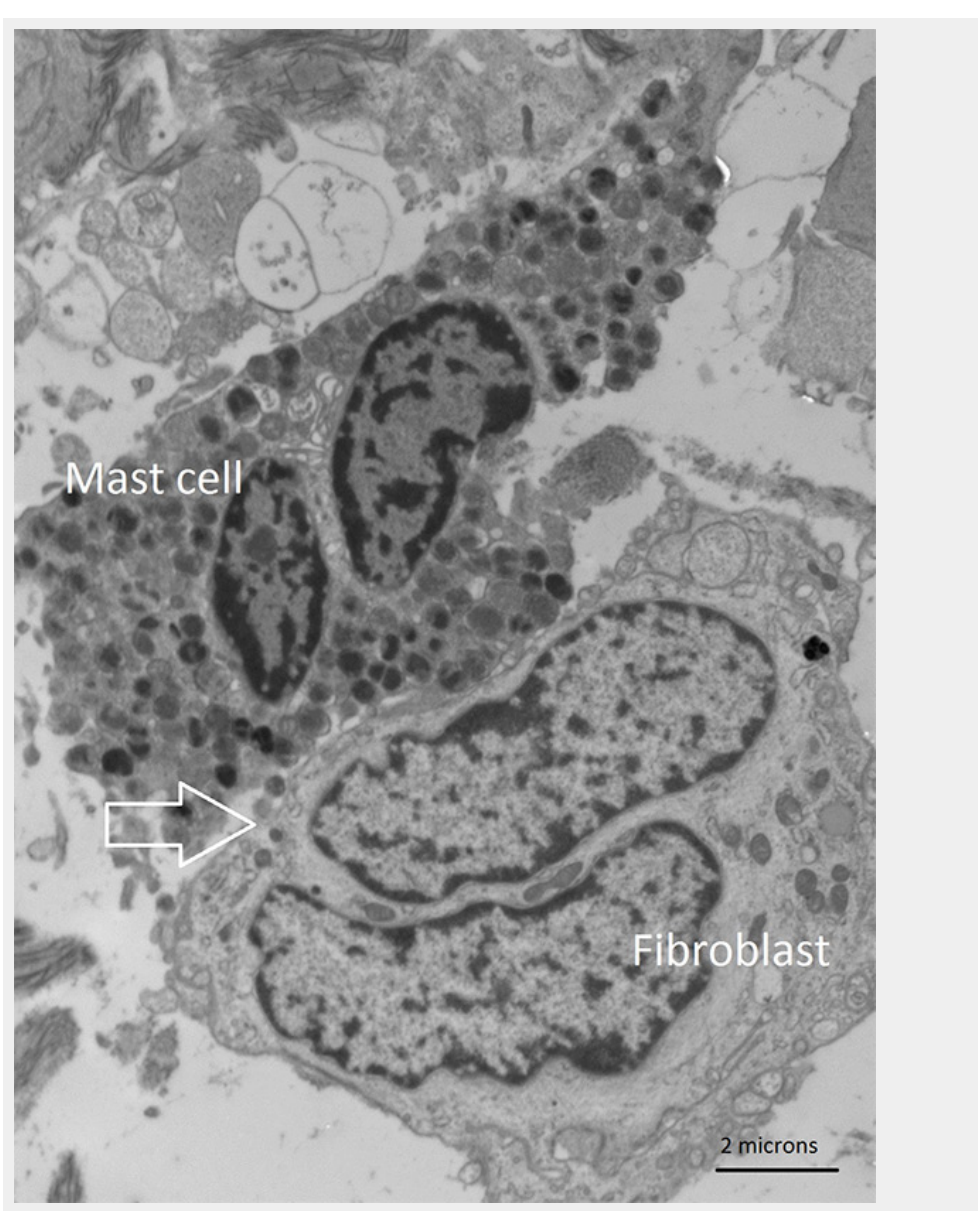
Figure 2 Transmission electron microscopy of the dermis in a patient with systemic sclerosis. The image shows cell-to-cell contact between a mast cell and a fibroblast with transgranulation